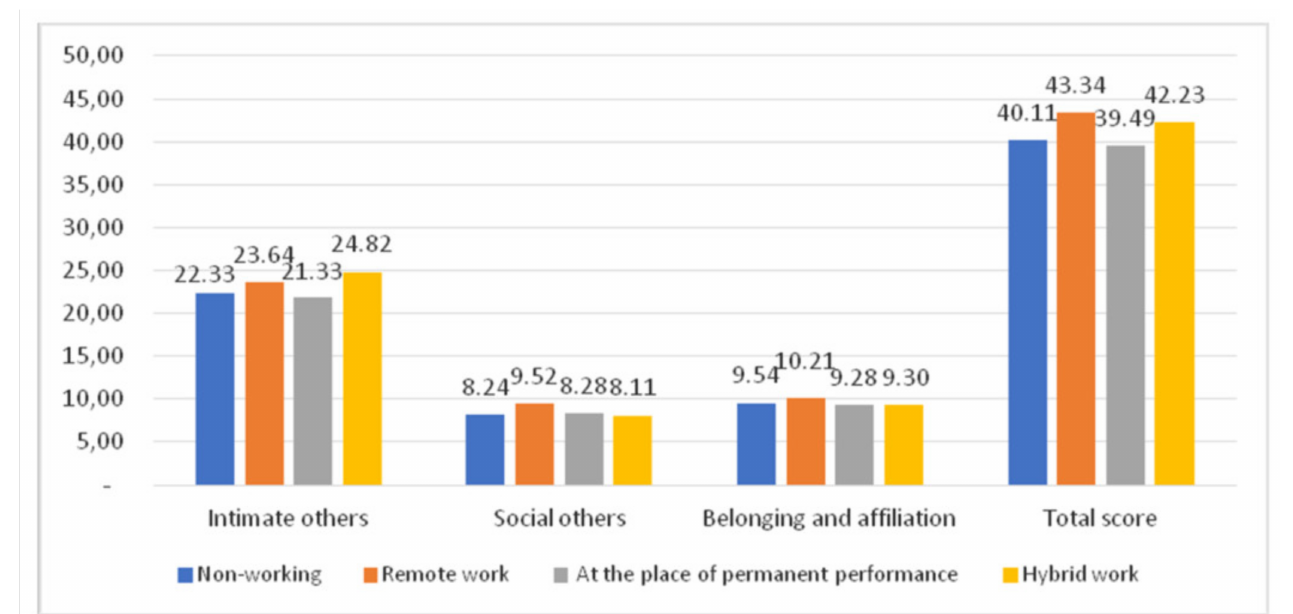
Figure 6. Place of work and the R-UCLA